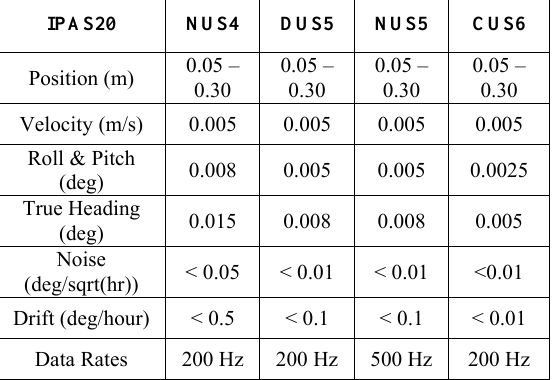
Table 1. Leica IPAS20 Specification (source: Leica)